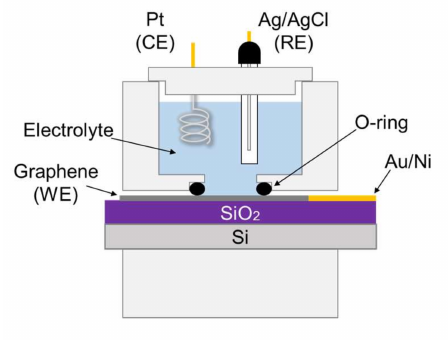
Figure 2. Electrochemical cell set-up used for all electrochemical measurements.